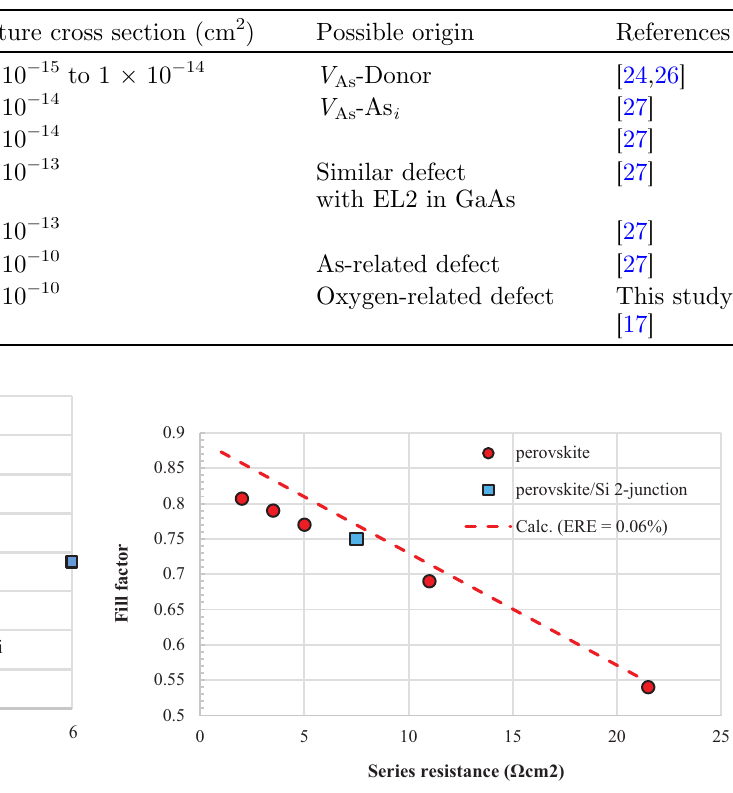
Fig. 8. Changes in fi ll factor for III – V multi-junction, III – V/Si tandem solar cells and perovskite/Si tandem solar cells as a function of number of junctions.